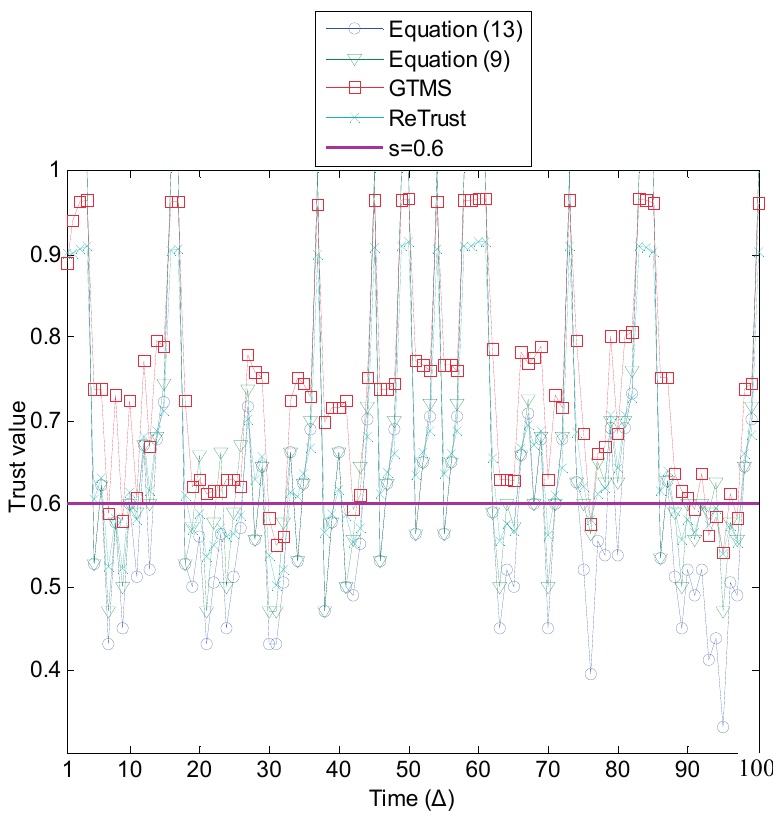
Figure 10. On-off attack detection (probability of an on period is